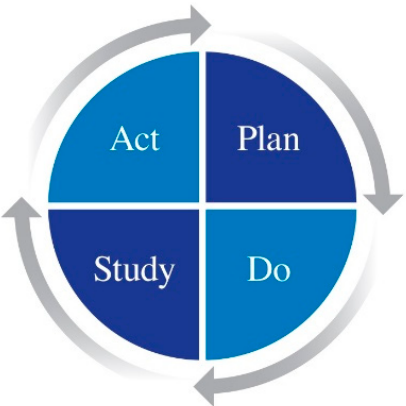
Figure 2. PDSA cycle (The W. Edwards Deming Institute ® , Ketchum, ID, USA).